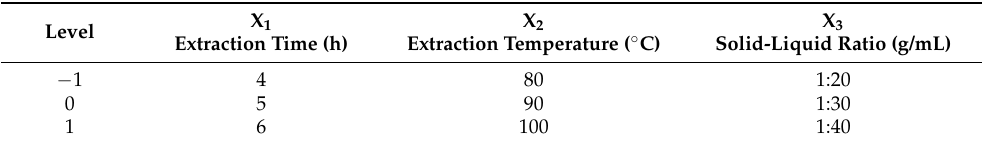
Table 2. Independent variables and levels in